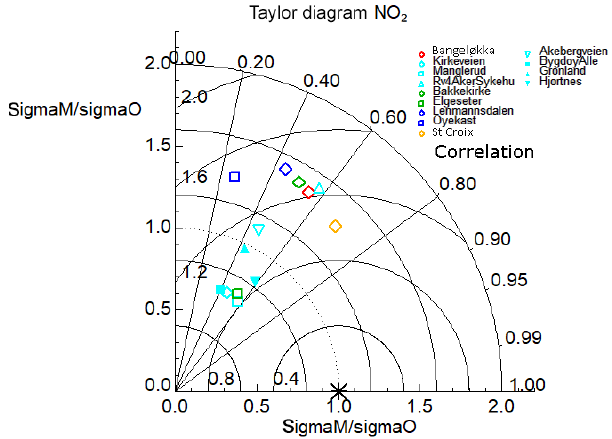
Figure 9. A Taylor diagram calculated using the winter-only (Jan- uary, February, and December) hourly time series of NO 2 concen- trations for all 16 in situ stations used for the model evaluation across all six domains. The symbols are colour-coded according to each model domain: Drammen is red, Oslo is cyan, Trondheim is green, Stavanger is pink, Grenland is dark blue, and Nedre Glomma is orange. The x and y axes both represent the ratio of the model standard deviation to the observed standard deviation in NO 2 con- centrations for a particular station such that points can be plotted on concentric circles centred on the x/y origin. The correlation is plotted according to the azimuthal angle from the origin represented as a series of straight lines emanating from the x/y origin. Lastly, the RMSE (µgm − 3 ) is also represented for each station according to their linear distance from 1.0 on the x axis.